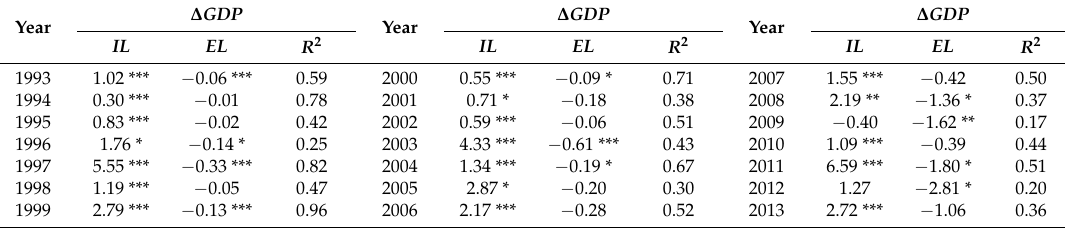
Table 2. Linear models of IL and EL with ∆ GDP across metropolitans in each year (Note: *, **, and *** indicate significance at 0.1, 0.05, and 0.01 level respectively; source: National Bureau of Statistics of